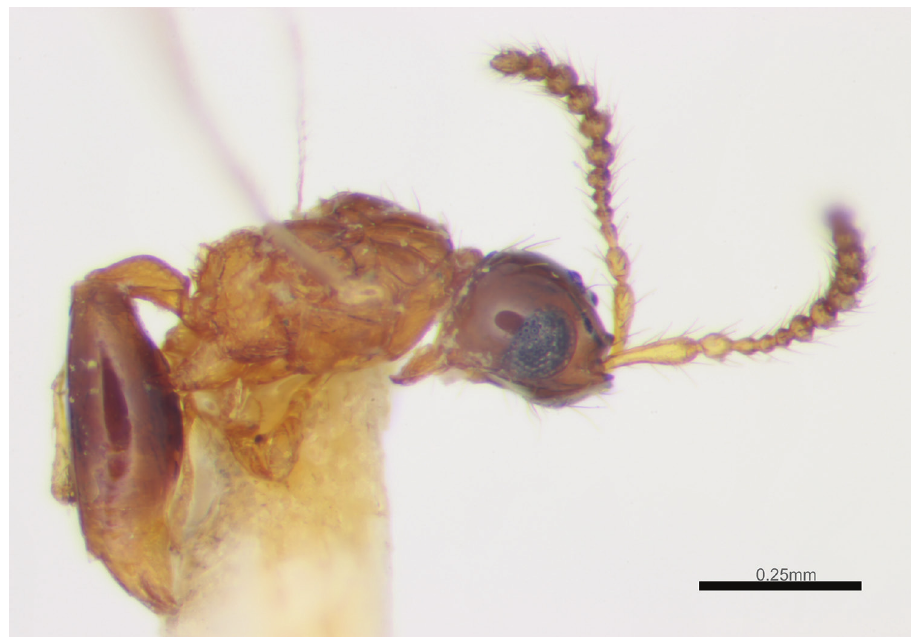
Figure 10. Calogalesus parvulus Kieffer, 1912, ♀ , holotype, habitus, lateral (Photo by Zi Hou, © The Trustees of the Natural History Museum,